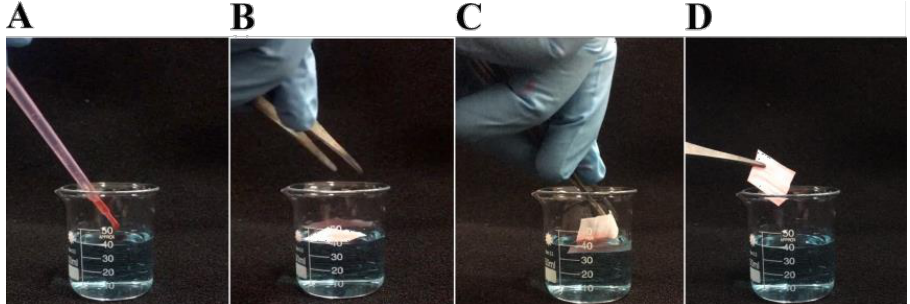
Figure 7. Modified cotton fabric absorbing floating oil layer ( A ) n-hexane in the water, ( B ) placing and immersing of modified cotton fabric on the surface of the water, ( C ) modified cotton fabric absorbing the n-hexane from water, and ( D ) n-hexane absorbed by the modified cotton fabric.